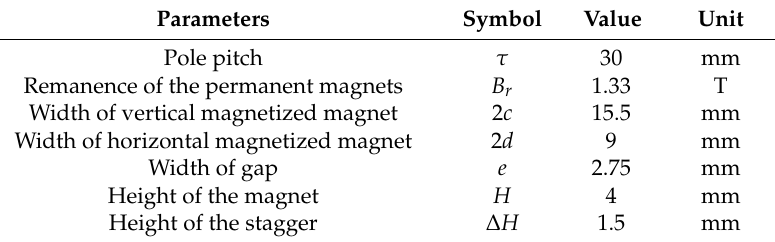
Figure 7. The magnet array built according to the optimized parameters.